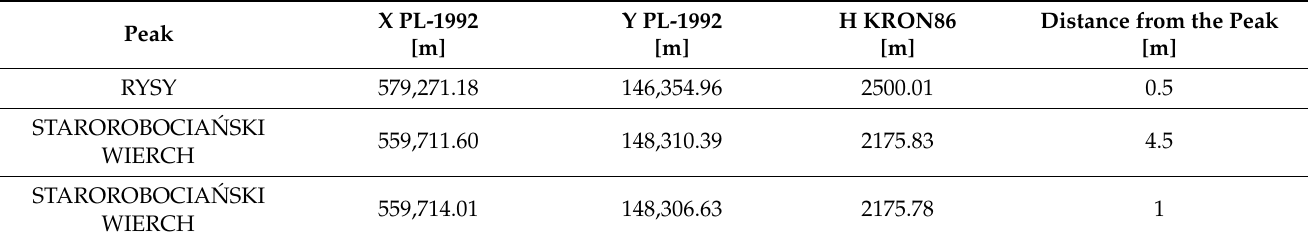
Table 4. Location and height of the highest Ground points in Polish datasets. X PL-1992 Peak